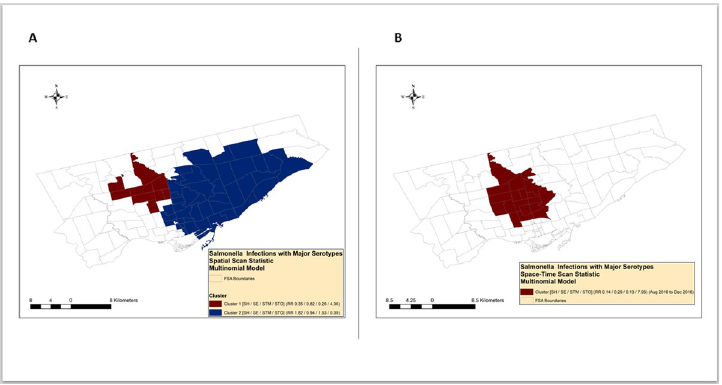
Fig 7. Spatial (A) and space-time (B) clusters of nontyphoidal Salmonella enterica infections with major serotypes identified by the multinomial scan statistic.